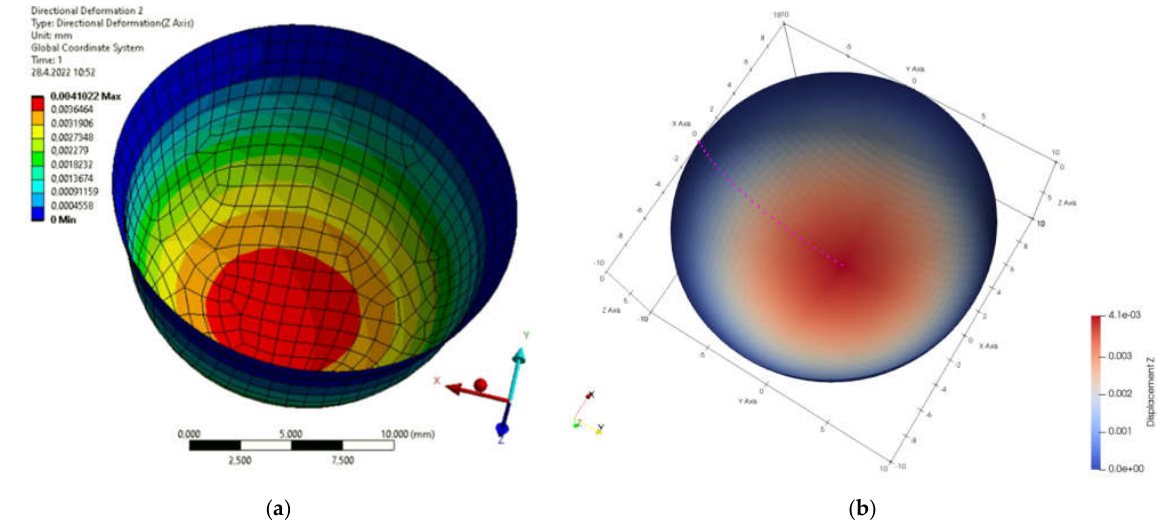
Figure 2. Displacements in load direction ( a ) FEM program; ( b ) MATLAB.